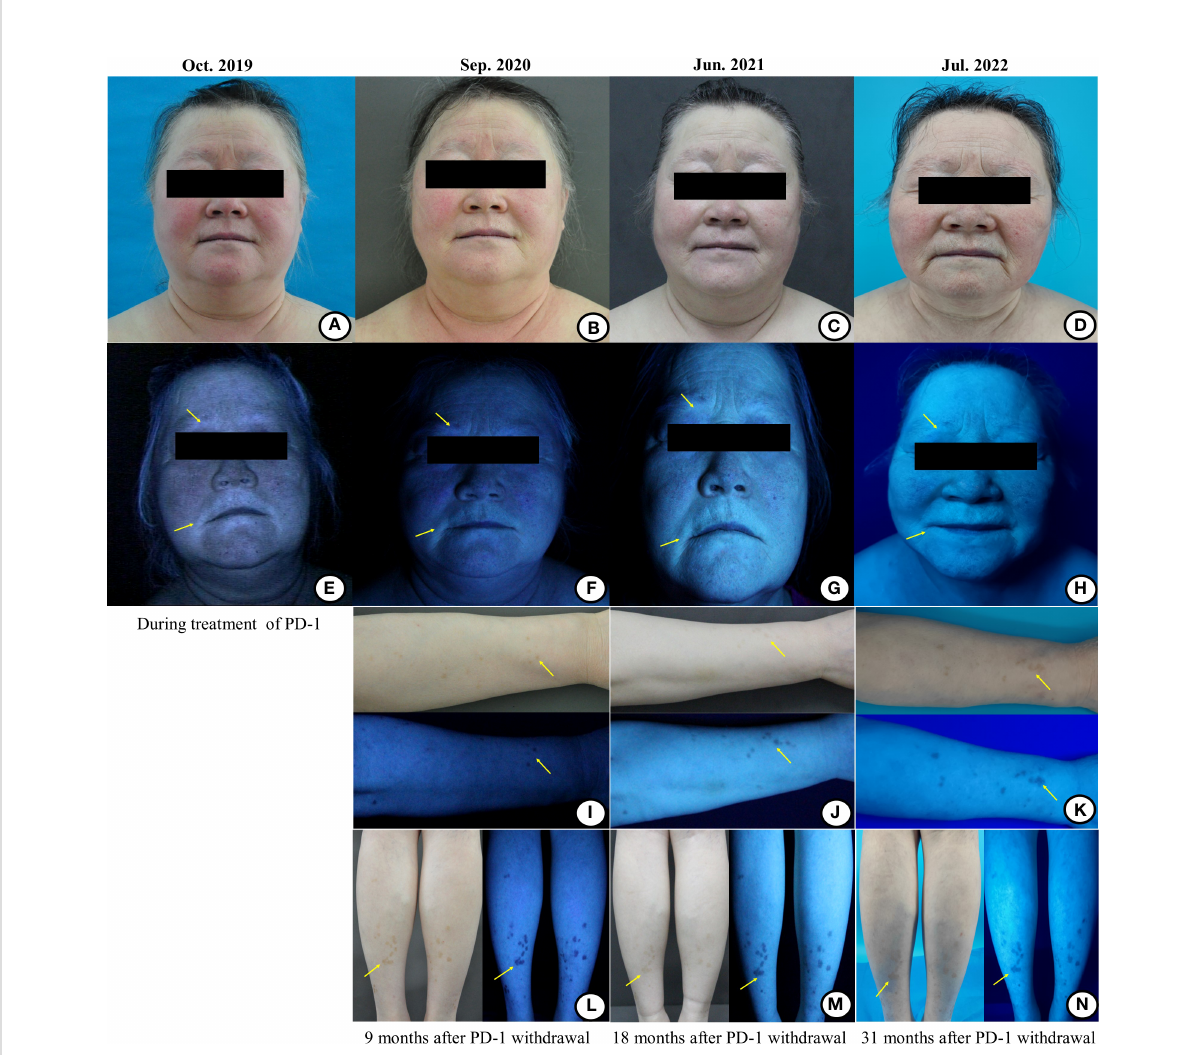
FIGURE 2 The images of the patient ’ s facial and limbs changes under the natural light and wood ’ s light during and after the treatment of the anti-PD-1 antibody. (A) During the treatment of immunotherapy, the vitiligo areas on the face were gradually enlarged, even involving the hair (including hair on the head/eyelashes/eyebrows), which showed depigmentation. (B – D) With the prolongation of immunotherapy withdrawal, the vitiligo areas on the face were gradually narrowed and the hair was gradually turned black. (E) Wood ’ s light examination showed that the vitiligo areas were bright bluish-white, and the hypopigmentation area was also found at the junction of the normal and depigmented skin. The hypopigmentation areas around the mouth under wood ’ s light examination presented a bright bluish-white signal. (F – H) With the prolongation of the immunotherapy withdrawal, the bright bluish-white areas on the mouth-around were gradually narrowed and faded. (I, L) Scattered pigmented spots began to emerge on the patient ’ s right forearm and lower legs under the wood ’ s light examination 9 months after stopping the immunotherapy. (J, M) The pigment macules of the right forearm and the lower legs became lighter than before under the natural light 18 months after stopping the immunotherapy, which may be related to the lack of sunlight during the winter in northern China. Under the wood ’ s light, the amount and range of pigmentation of the right forearm were increased than before, while the macules on lower legs were stable 18 months after the immunotherapy withdrawal. (K, N) With the prolongation of the immunotherapy withdrawal, the amount and range of pigmentation of the right forearm and lower legs were further increased and expanded than